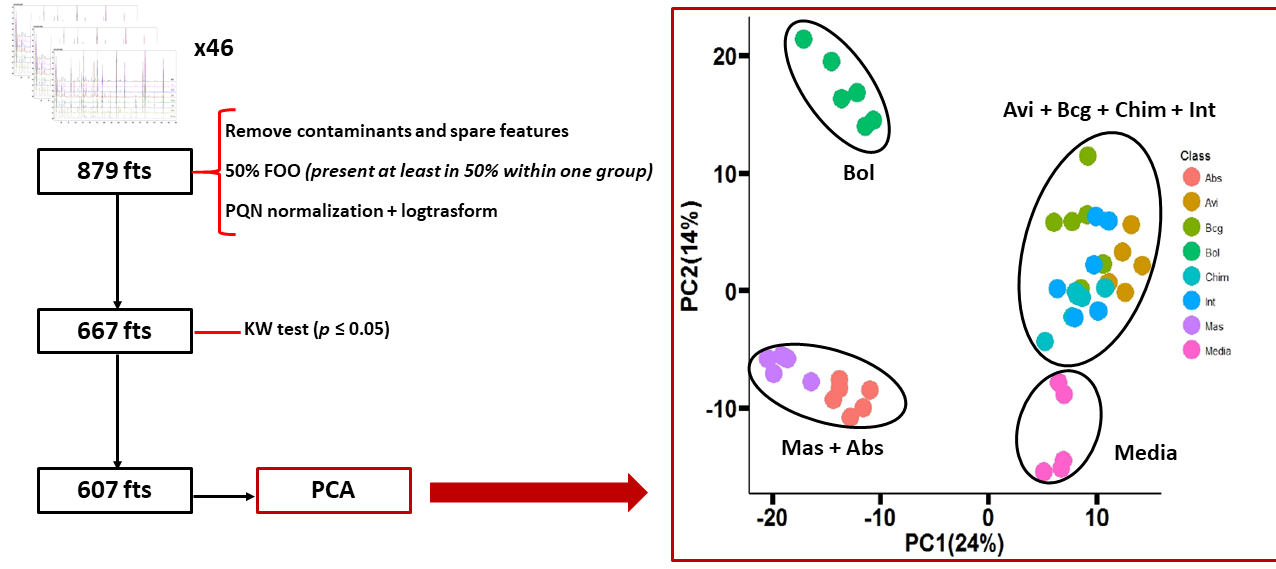
Figure 3. On the left, the data processing flow-chart, from the generation of the data matrix after the alignment to the feature’s reduction after KW test ( p ≤ 0.05). On the right, the PCA of seven mycobacteria species + medium plotting the 607 volatile significant features. Table 1. Panel of 13 discriminatory features of seven mycobacteria species after random forest data reduction. Number of features, chemical name, CAS number, MS similarity (%), LRI calculated, LRI in NIST library (LRI lib) and retention time (Rt) are also reported. FT n.